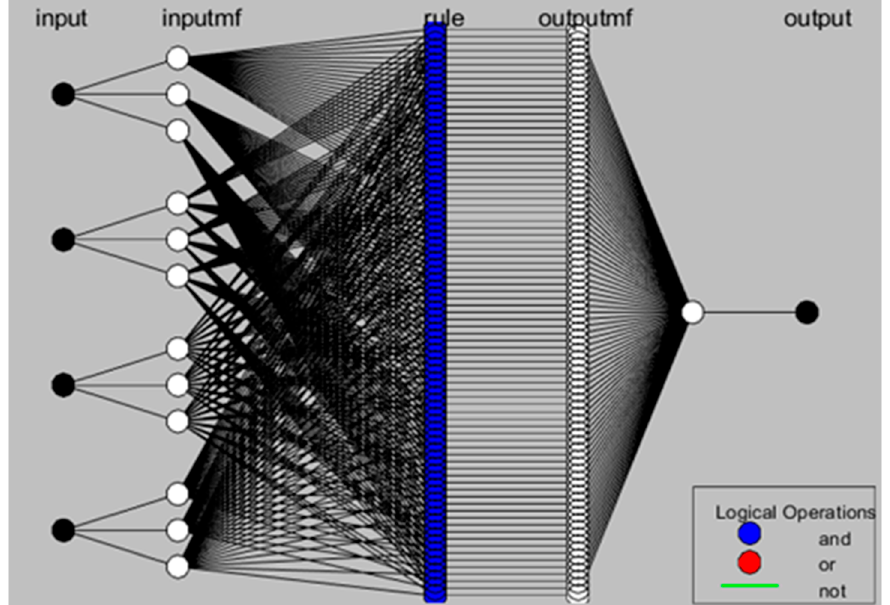
Figure 17. ANFIS structure developed using grid partitioning.